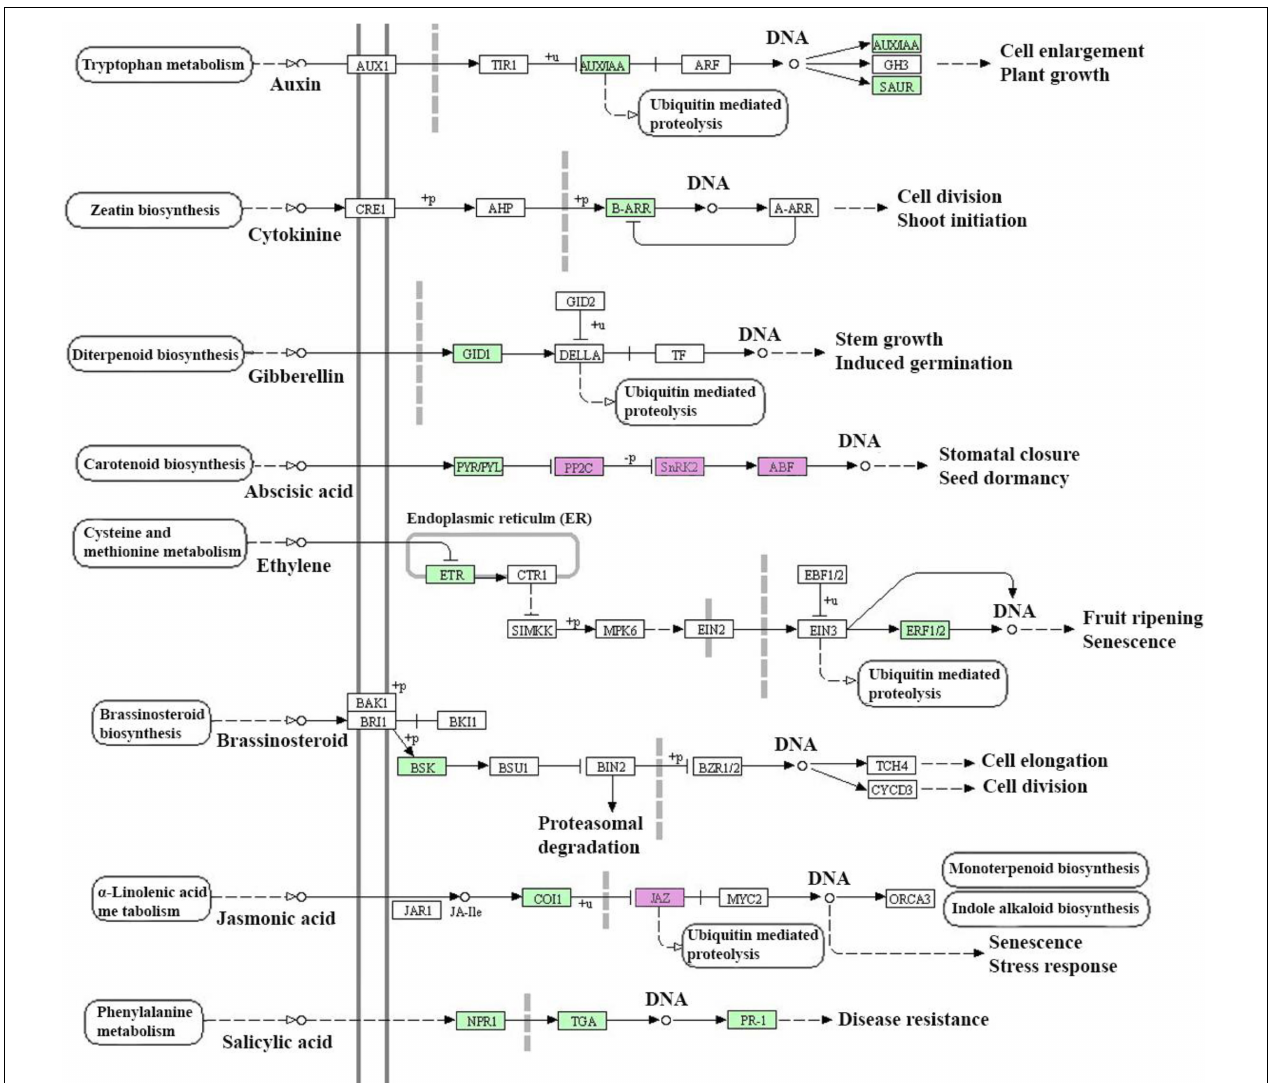
FIGURE 3 | Plant hormone signal transduction detected in response to salt stress conditions (300 mM NaCl) in barley. This figure provides only a KEGG pathway for up-regulated genes in the salt-tolerant genotype and salt-sensitive cultivar. Purple color boxes represent the common differentially expressed genes (DEGs) between salt-tolerant and salt-sensitive barleys and green color boxes represent the specifically DEGs in salt-tolerant genotype. EC number of the encoded enzyme is shown in each